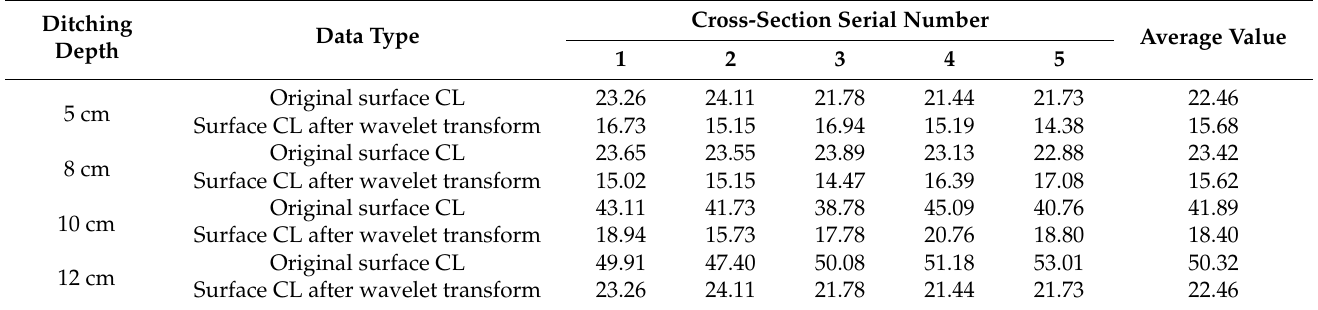
Table 2. Statistical results of original surface and surface CL after wavelet transform with different tillage depth.